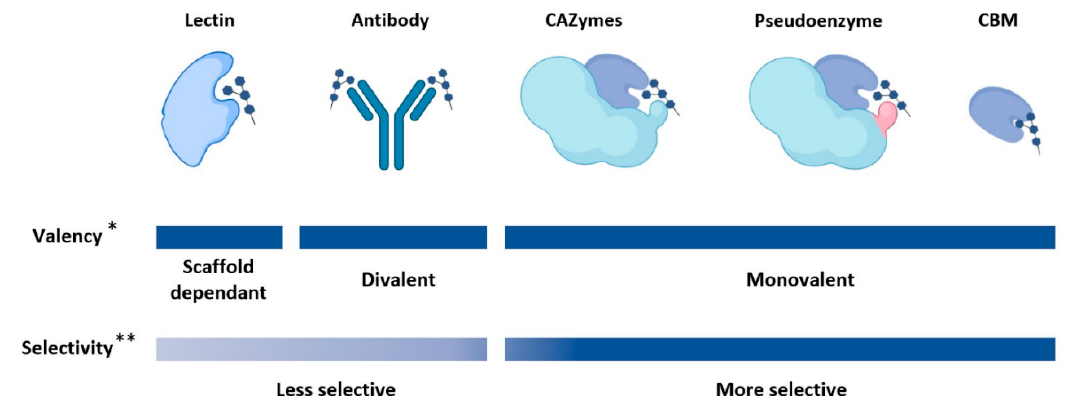
Figure 1. Valency and selectivity of protein scaffolds with glycan binding sites. The valency of lectins and antibody-based scaffold varies, as some lectins contain tandem repeat units and antibody-based scaffolds can be designed to contain only a single, or multiple variable fragments. Similarly, CBMs can be designed in tandem to increase valency. The selectivity of antibody-based scaffold is affected by the poor immunogenicity of carbohydrates. * It should be noted that the valency of lectins, antibodies, and CBMs can be altered with protein engineering. ** There are exceptions to this trend and the selectivity can be affected by valency.